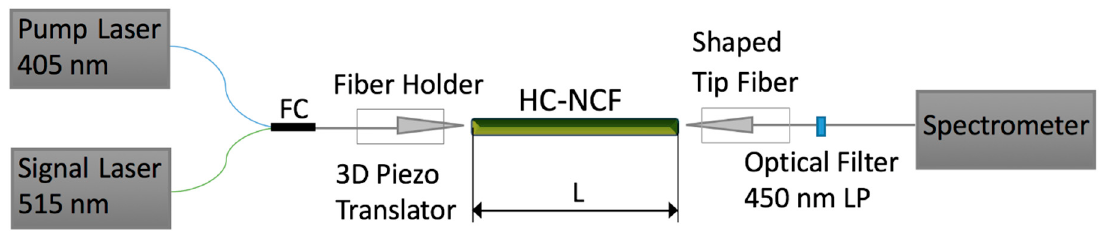
Figure 2. Experimental setup for optical gain measurements, consisting of two tip-shaped fibers coupled at both ends of the HC-NCF facets. CW-pump (405 nm) and probe signal (515 nm) beams are combined inside the first fiber by a fused fiber coupler (FC), whereas the second fiber collects light at the output of the HC-NCF into a spectrometer after a 450 nm long-pass filter.